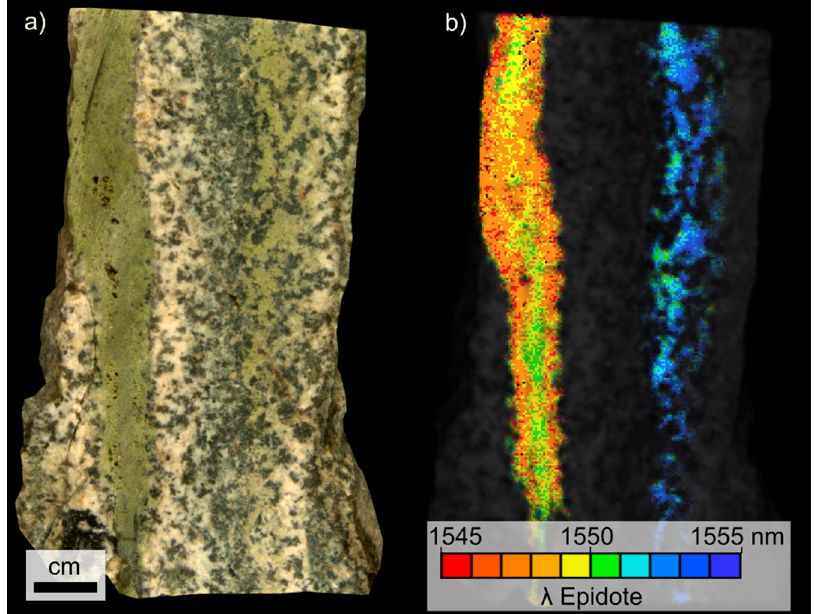
Figure 7. Non-mineralized sample 2015KB102 (21 ppm Cu) from the propylitic alteration zone of the Guichon lithofacies, 3 km east of the Bethlehem deposit. ( a ) Sample photograph. ( b ) Hyperspectral imagery processed to display the position of the 1550 nm absorption feature of epidote.